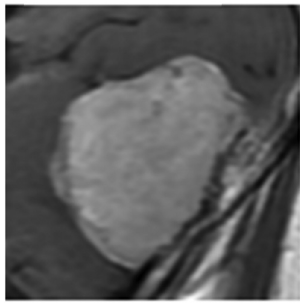
Figure 8: Cropped input image.